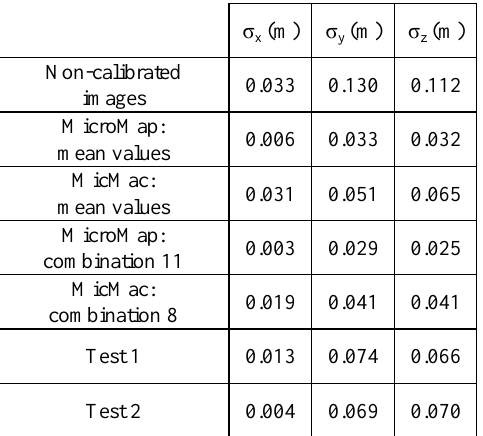
Table 3. Standard deviations, σ (m), of the residuals computed on